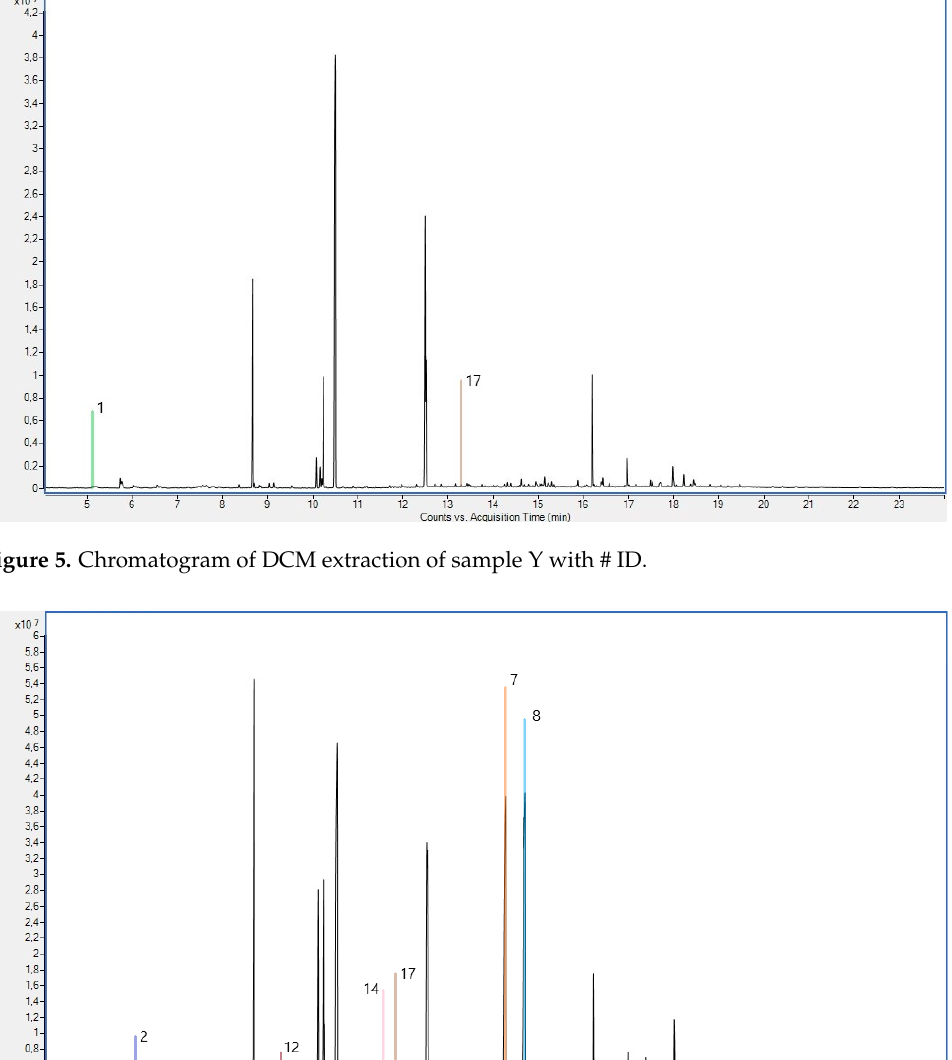
Figure 4. Chromatogram of DCM extraction of sample X with # ID.